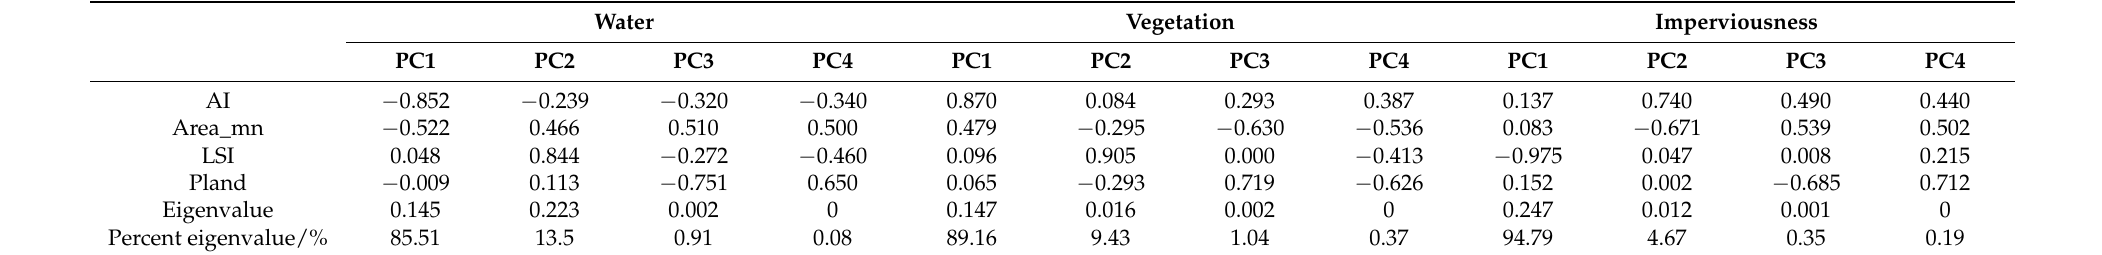
Table 3. Principal component analysis of the comprehensive index for each